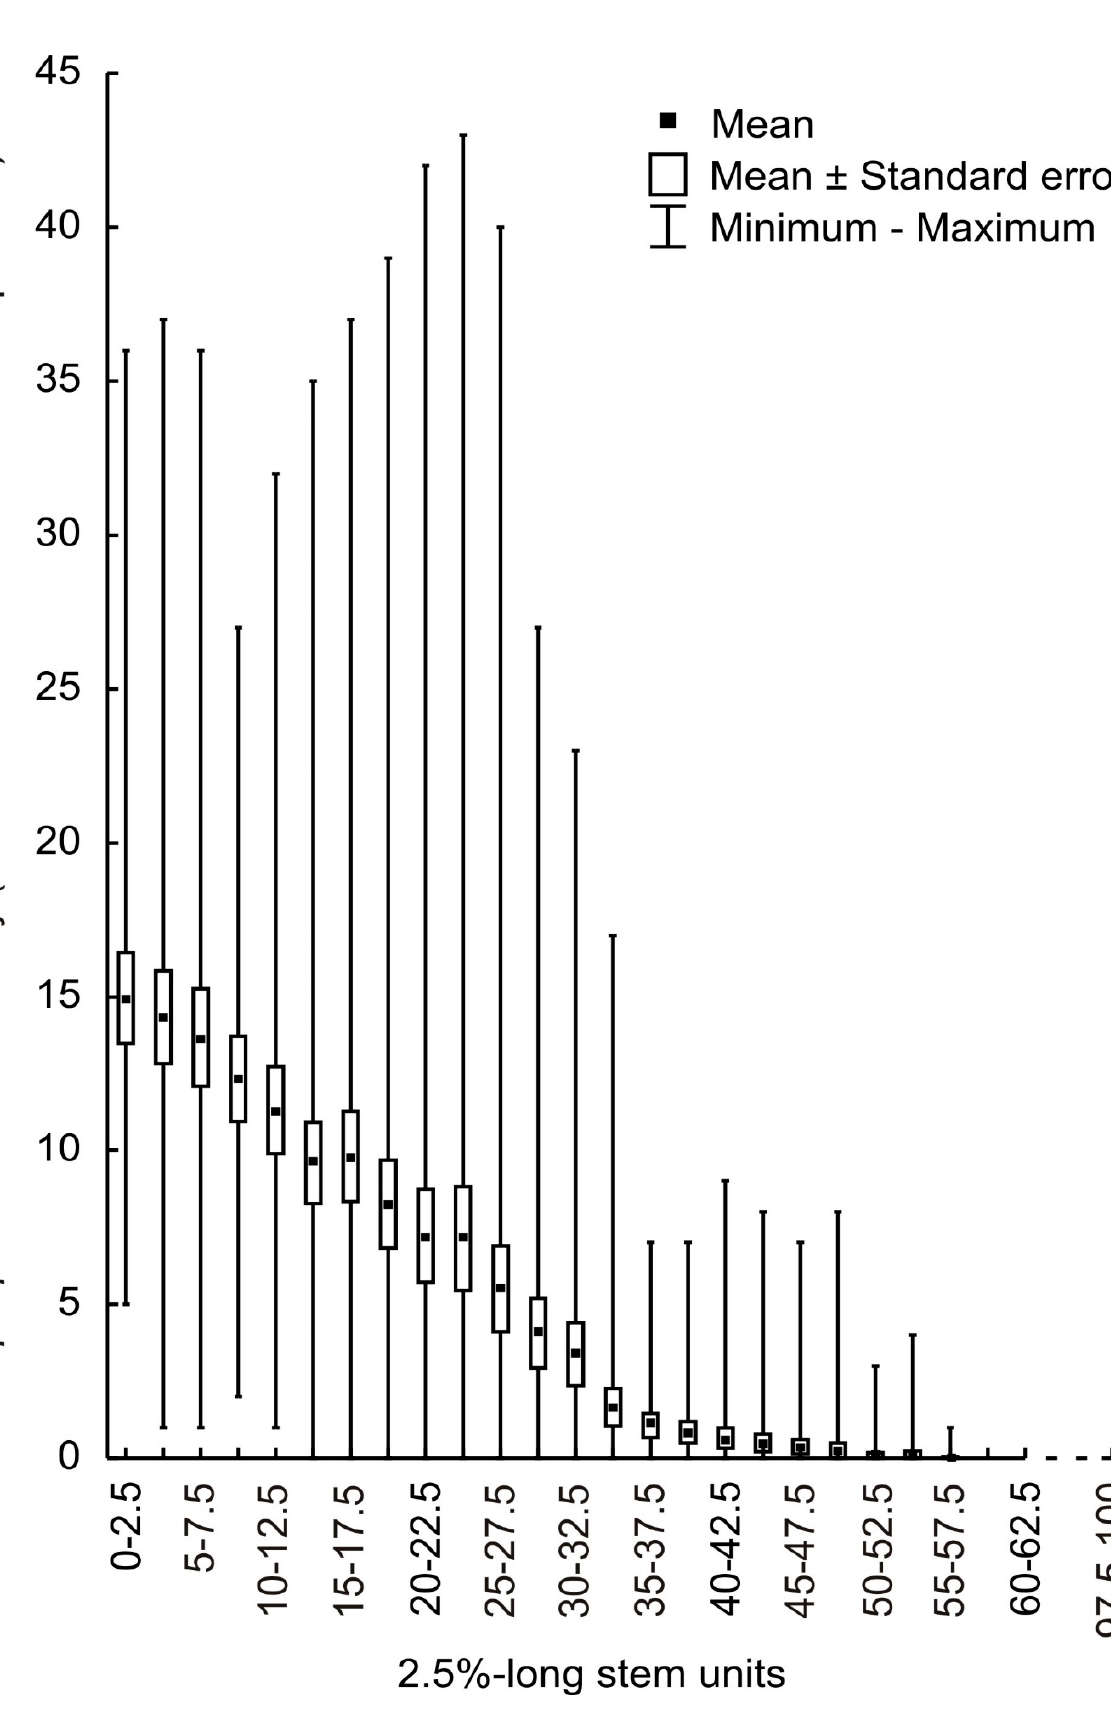
Figure 3. Distribution of T. piniperda on P. sylvestris trap trees in 2.5%-long stem units in sample plots.